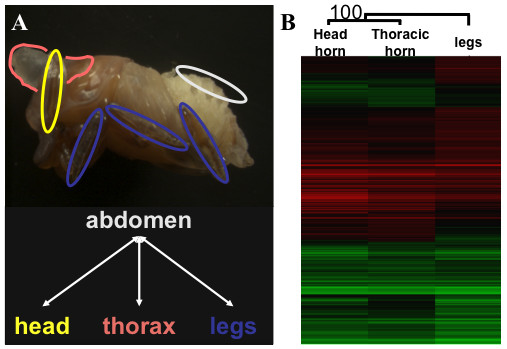
Experimental design and clustering analysis of the gene expression pattern in O. taurus day 1 pupa. A. Microarray experimental design. The pupal tissues used are indicated in the upper panel and the microarray hybridizations are illustrated in the lower panel. Head horn (head) is labeled yellow, thoracic horn (thorax) is labeled pink, legs are labeled blue, and abdominal epithelium (abdomen) is labeled white. B. Hierarchical clustering of differentially expressed genes. 1,367 spots were clustered based on their M-values when compared to abdominal epithelium. Each row represents a single spot and each column represents the sample. Relative magnitude of gene expression level is indicated by color brightness; red indicates enriched compared to abdominal epithelium whereas green indicates depleted relative to abdominal epithelium. M-values ranged from -4.85 to 4.12. Bootstrap values were obtained after 5000 trials. Branch lengths represent relative distances between the samples.